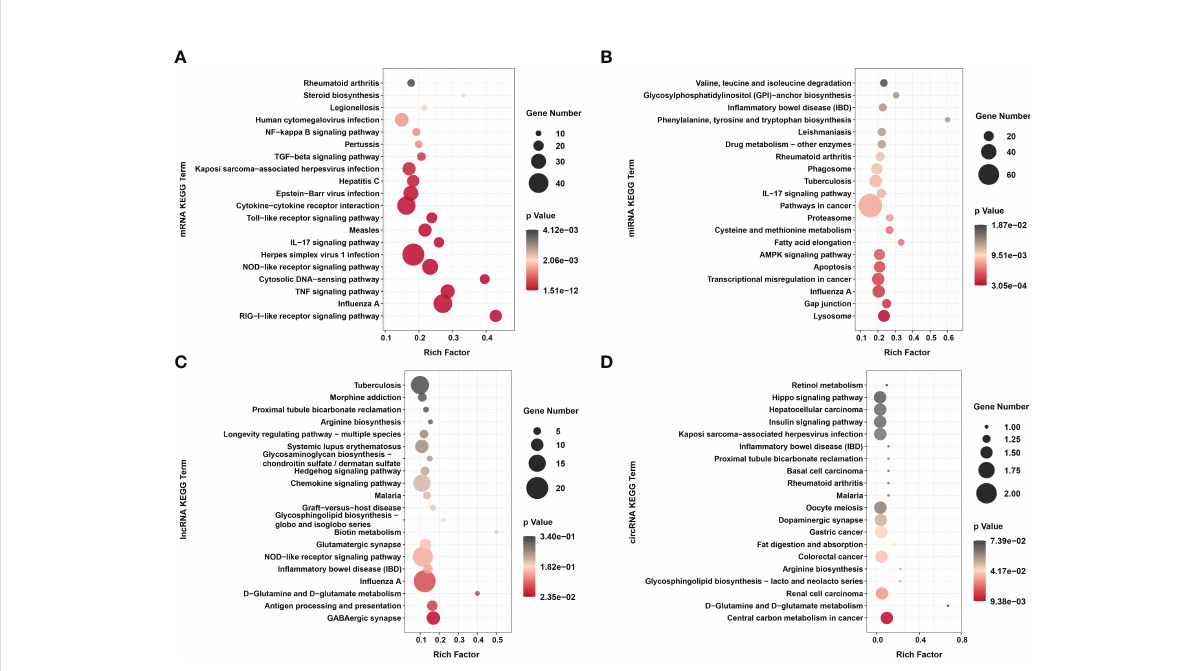
FIGURE 5 KEGG enrichments of (A) dif-mRNAs, target mRNAs of (B) dif-miRNAs, (C) dif-lncRNAs, and (D) host mRNAs of dif-circRNAs. Top 20 KEGG pathways were shown. Rich factor indicated the ratio of dif-mRNAs enriched to the speci fi c pathway. The size and the color of the solid circulars represented the number of enriched dif-mRNAs and signi fi cance of the enrichment,